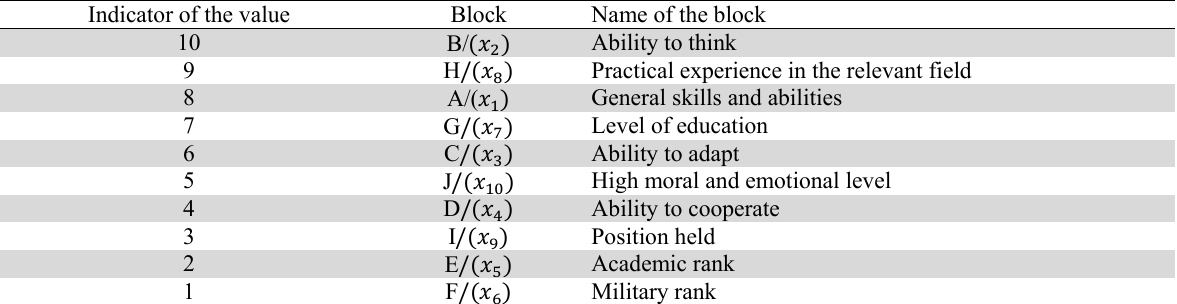
Ranking of the blocks of competencies of the expert evaluation Indicator of the value